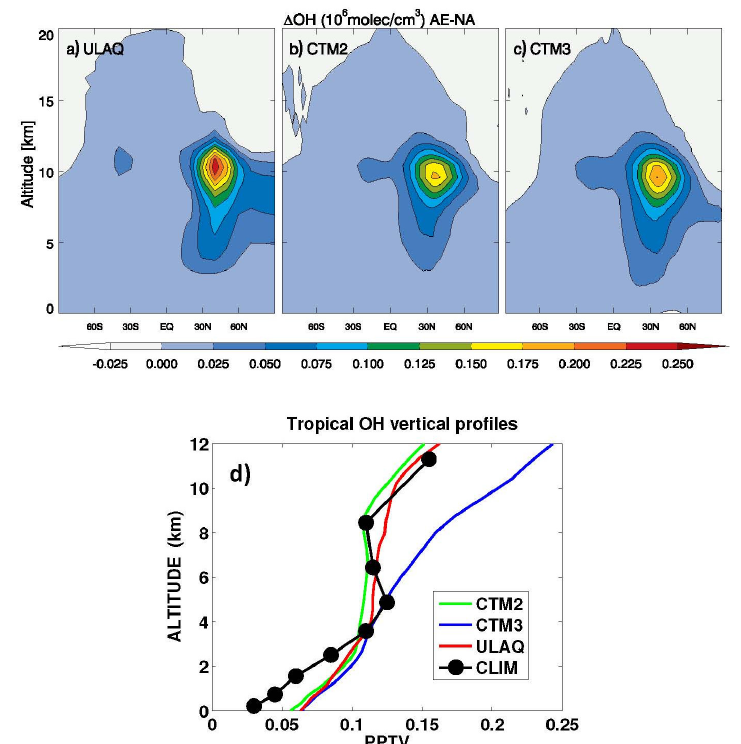
Figure 8. Top panels: zonally and annually averaged OH changes produced by aircraft emissions (AE-NA), for ULAQ (left panel ( a )), CTM2 (mid panel ( b )) and CTM3 (right panel ( c )), respectively. Units are 10 6 molec/cm 3 . Bottom panel ( d ): annually averaged vertical tropical profiles of OH mixing ratio (30S–30N) (pptv) from the three models, compared with climatological values